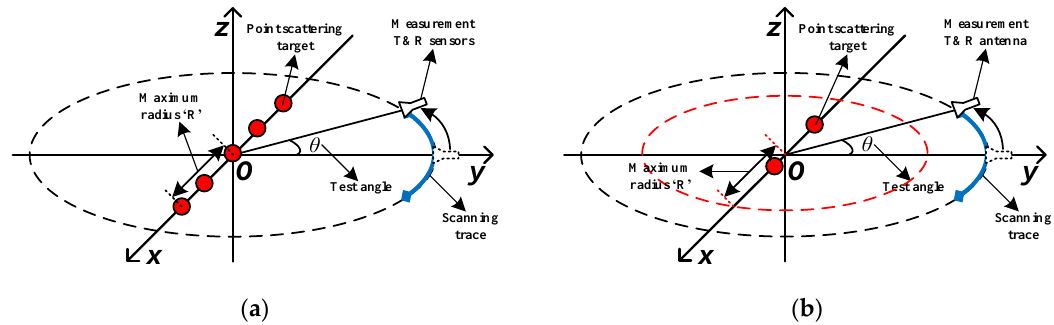
Figure 5. Point scattering model and near-field measurement setting ( a ) an example of 5-points model ( b ) an example of a randomly placed 2-points model.